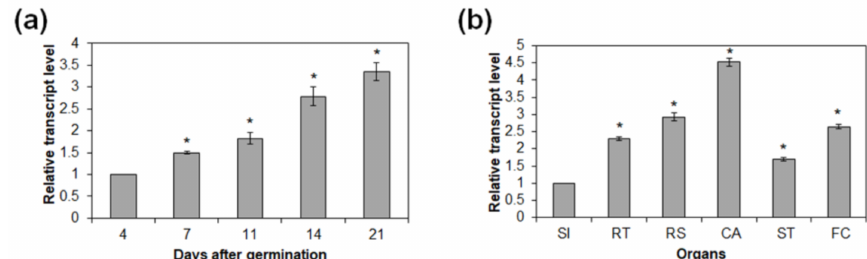
Figure 5. Temporal and spatial expression patterns of AtRH17 . ( a ) Quantitative RT-PCR analysis of AtRH17 in 4-, 7-, 11-, 14-, and 21-day-old WT seedlings grown under short-day (SD) conditions. GAPc was used as an internal control. Transcript level at 4 days after germination (DAG) was set as 1. ( b ) Quantitative RT-PCR analysis of AtRH17 expression in organs of 36-day-old mature WT grown under long-day (LD) conditions. GAPc was used as an internal control. Transcript level in SI was set as 1. SI, siliques; RT, roots; RS, rosette leaves; CA, cauline leaves; ST, stems; FC, floral clusters. Three independent reactions were performed for each technical replicate. Two technical replicates were performed for each biological replicate. At least two biological replicates showed similar results, with one shown here. Error bars represent standard deviation ( n = 6 reactions) and * indicate t -test p <